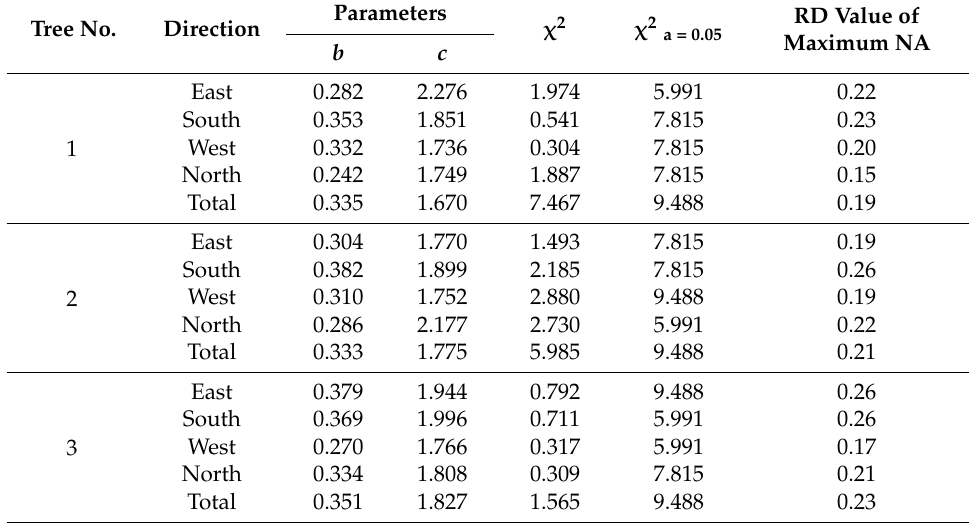
Note: Tree No. = tree number, RD = ratio of the projective length from the tip to stem junction to the crown width, NA = needle area.